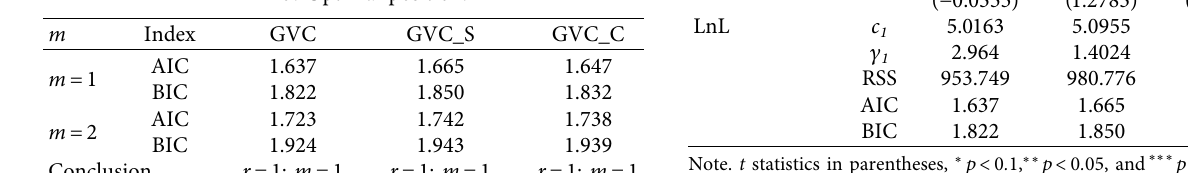
Table 3: Optimal position.